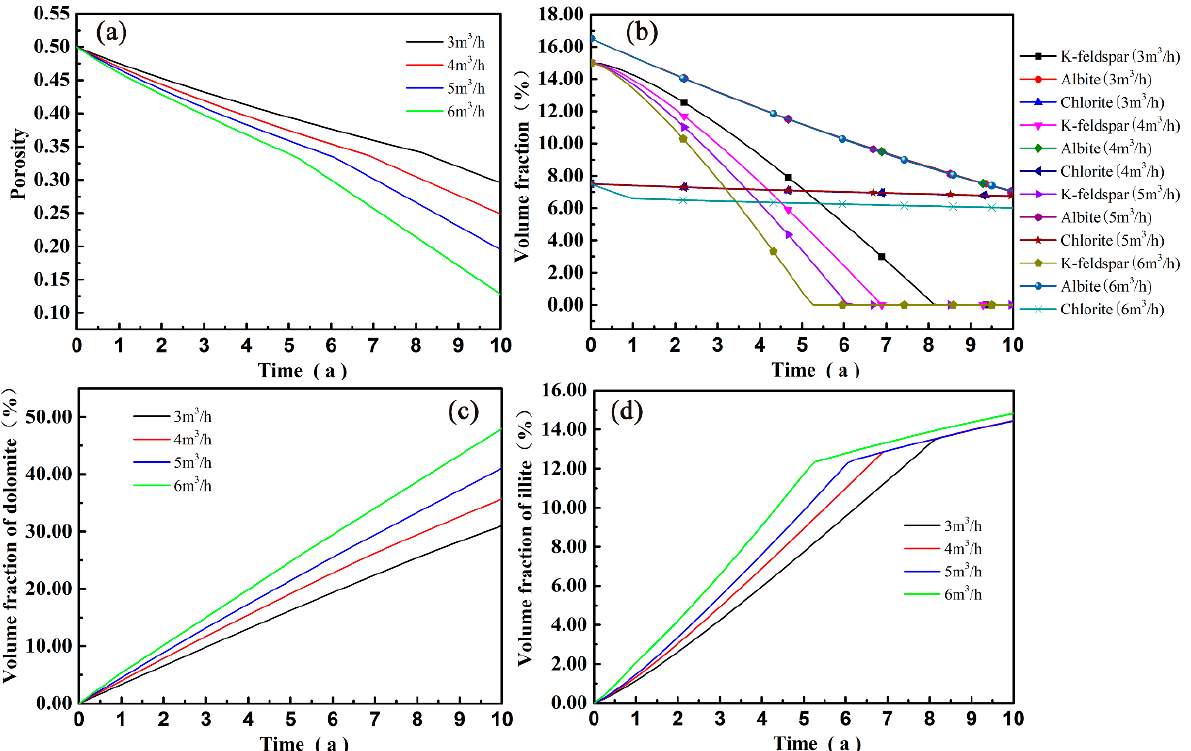
Figure 9. Simulation results at different injection flow rates. ( a )—Porosity; ( b )—Permeability; ( c )— Dolomite; ( d )—Illite.